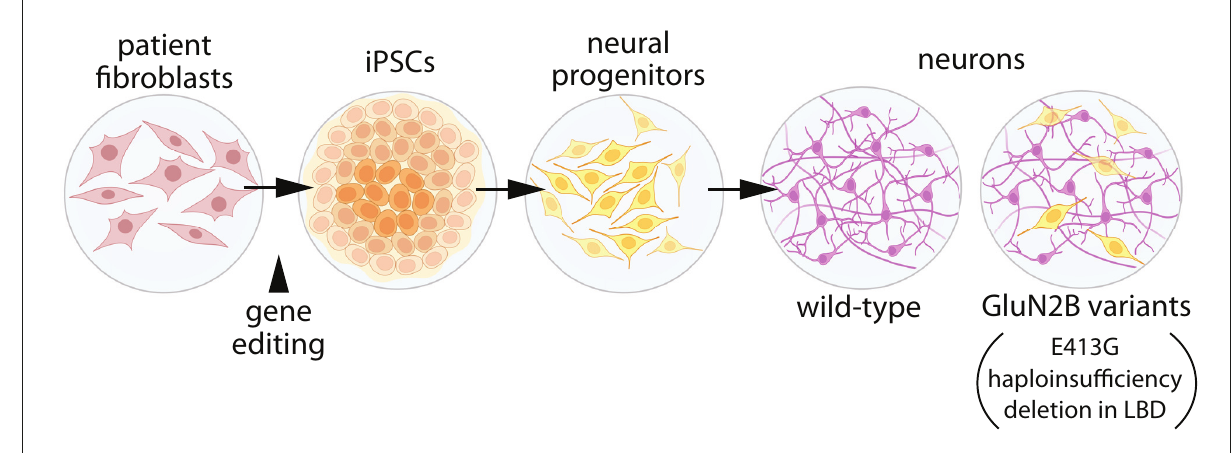
FIGURE2 Expression of GluN2B variants interferes with neuronal differentiation. Induced pluripotent stem cells (iPSCs) were generated with either: (1) GluN2B harboring the disease-associated missense mutation, E413G, within the ligand-binding domain (LBD); (2) deletion of a section of the GluN2B LBD, or (3) GluN2B haploinsufficiency (Bell et al., 2018). Neural progenitor cells were generated from iPSCs, then differentiated into forebrain neurons. In differentiated cells with GluN2B variants, expression of genes related to cell proliferation and pluripotency was elevated, while genes associated with neuronal differentiation were reduced, when compared to cells with two alleles of wild-type GluN2B. Illustrations were partially created with BioRender.com.